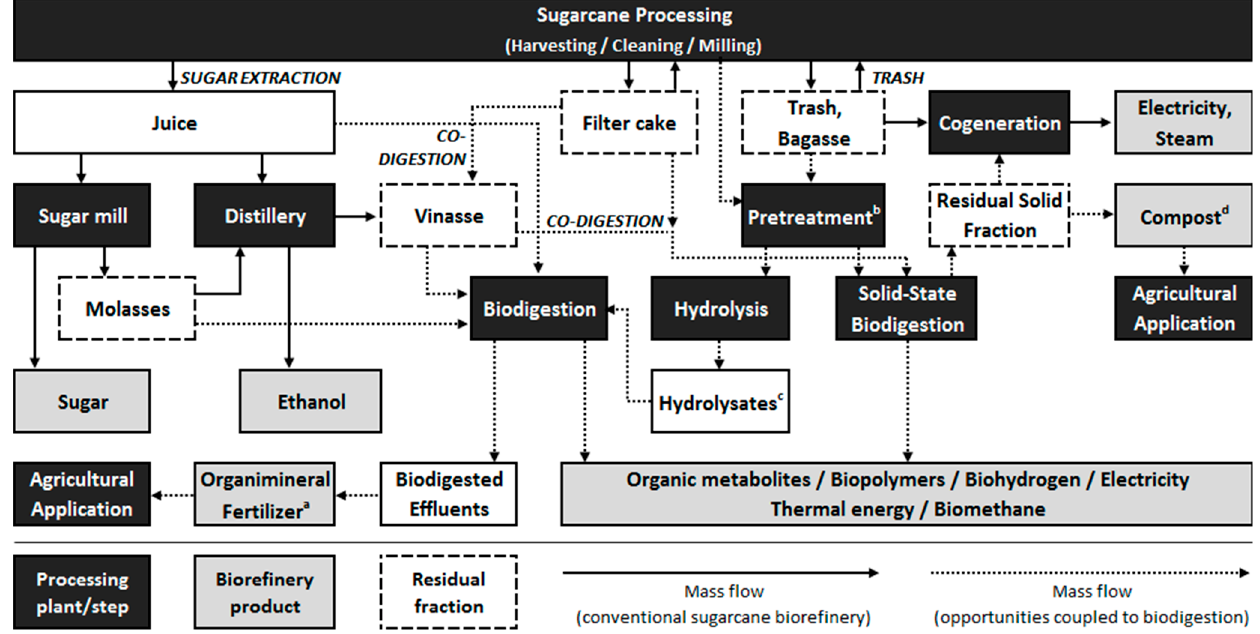
Figure 5. Opportunities for inserting biodigestion in 1G sugarcane biorefineries. Notes: a Requires the post-treatment of the effluent, such as concentration, blending with other residual streams (e.g., filter cake), and mineral supplementation. b Aims to reduce the recalcitrance of the lignocellulosic materials. c Composed of pentoses and hexoses. d Requires the post-treatment of the digestate, such as mineral supplementation.